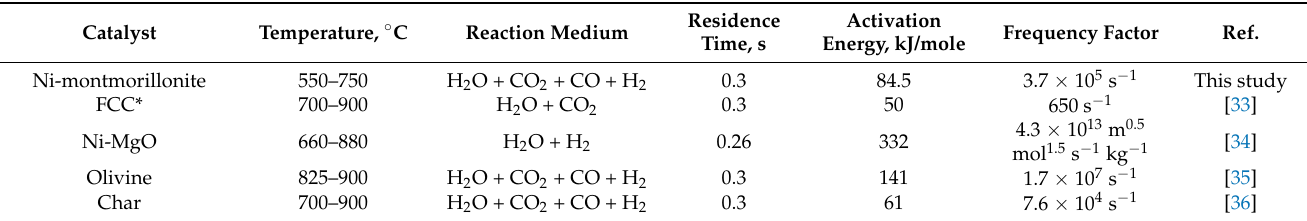
Table 7. Comparison of kinetic data for decomposition of naphthalene over various catalysts.